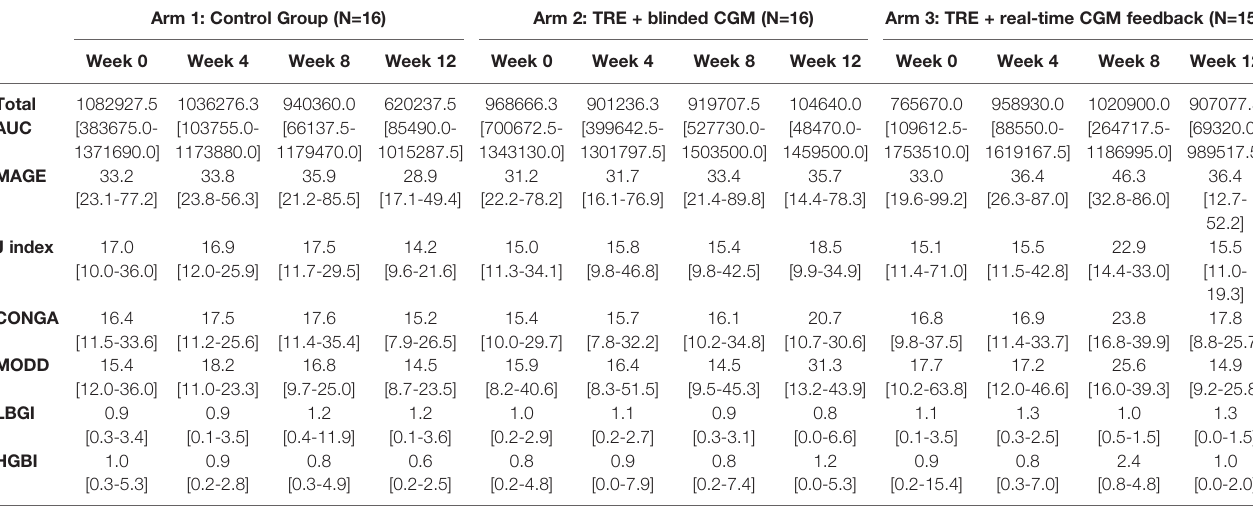
TABLE 2B | Calculated glycemic variability metrics. Arm 1: Control Group (N=16) Arm 2: TRE + blinded CGM (N=16)